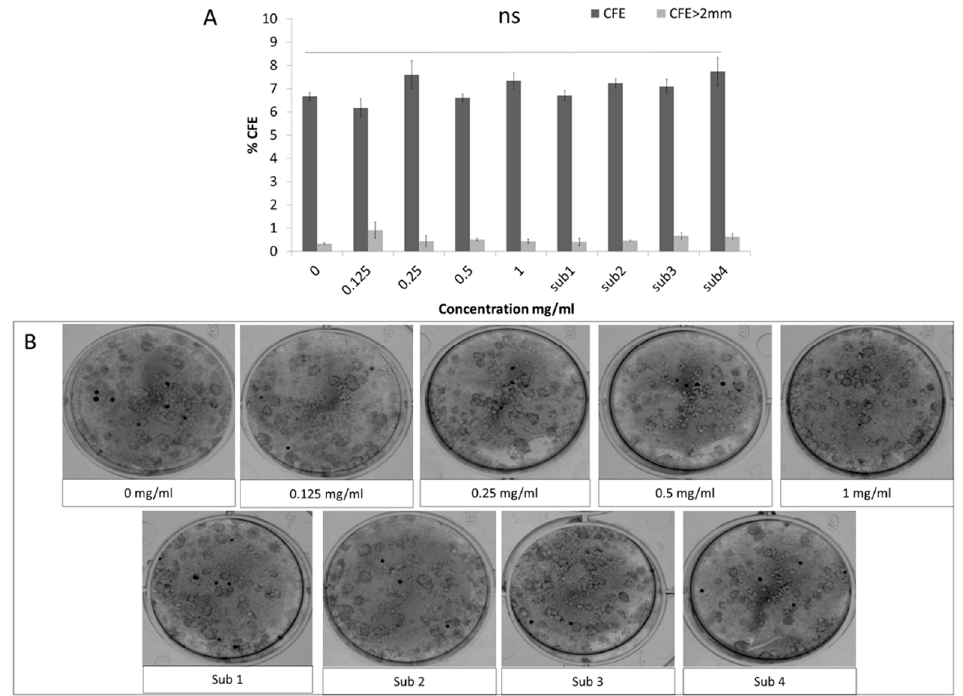
Figure 2. The colony forming efficiency (CFE) of presumed limbal epithelial stem cells remained unaffected following Bevacizumab treatment. Total colonies percentage as well colonies with a diameter greater than 2 mm were unaffected by Bevacizumab treatment ( A ). Panel B shows representative Rhodamine B colony stainings from all treatment groups ( B ).Number of replicates n =